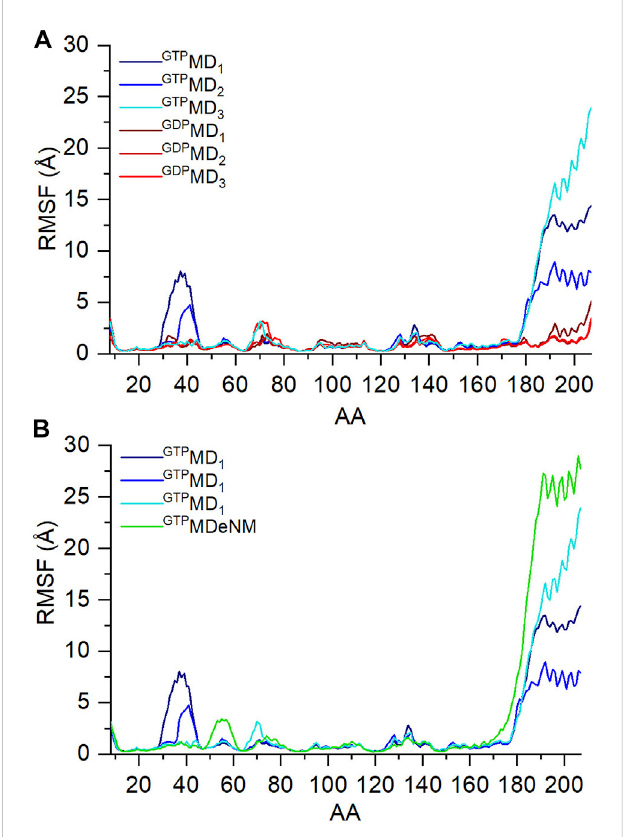
RMS fl uctuation values of C α atoms during the three independent MD simulations of (A) ran-GDP (shades of red) and ran-GTP (shades of blue); and (B) of ran-GTP during MD (shades of blue) and aMDeNM (green)